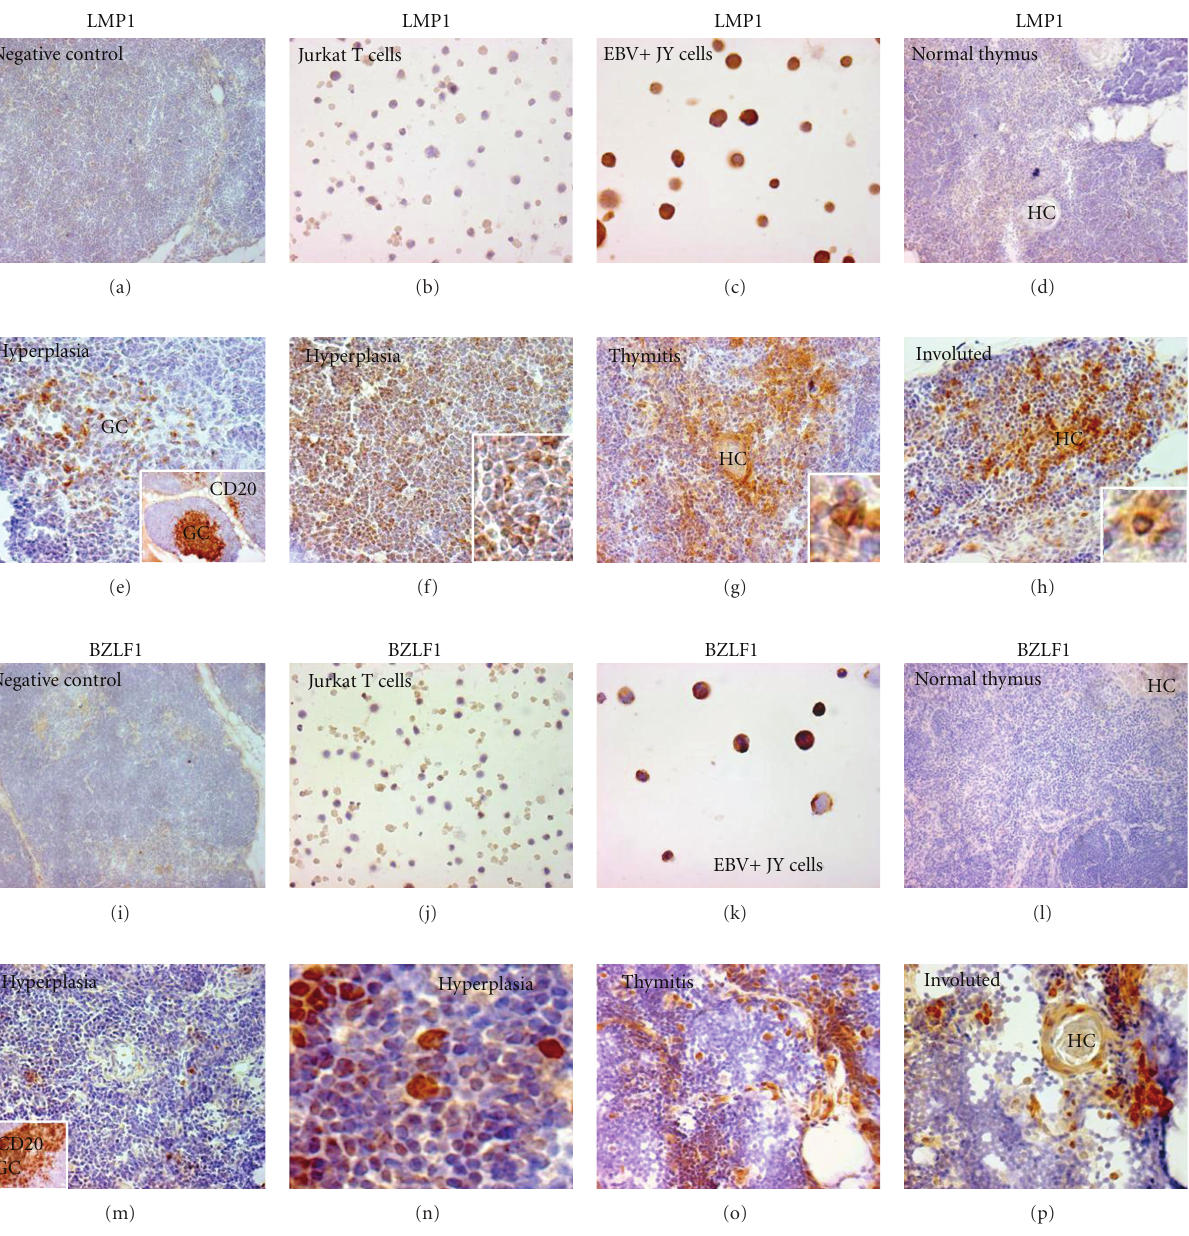
Figure 6: Immunohistochemistry for latent LMP1 (a)–(h) and lytic BZLF1 (i)–(p) EBV proteins. (a) to (h) LMP1 immunostaining. No signal of immunoreactivity was observed in negative control performed by incubating sections with isotype-specific nonimmune IgG (Dako) (a). LMP1 was not detected in EBV-negative Jurkat T-cell line (b) but was readily detectable in EBV-positive JY cells (c). Normal thymuses showed no immunoreactivity for LMP1 antibody (d). In hyperplastic thymuses (MG1 is shown), LMP1+ cells were detected in areas containing CD20+ B cells organized in germinal centers (GCs) ((e) and inset in (e)) or were di ff used throughout the highly infiltrated medullary region (f). Numerous LMP1+ cells were identified in thymitis cases (MG13 is shown), that were di ff used in thymic medulla and frequently located around Hassall’s corpuscles (HCs), where often concentrate B cells (g). In involuted thymuses (MG16 is shown), numerous LMP1+ cells were scattered in the residual thymic parenchyma and frequently located in thymic infiltrated areas around HCs (h). Inset in (e) shows CD20 immunostaining of the same area of the main panel in a serial section. Insets in (f), (g), and (h) show areas of the main panels at higher power of magnification to reveal membrane localization of LMP1. (i) to (p) BZLF1 immunostaining. No signal of immunoreactivity was observed in negative control performed by incubating sections with isotype-specific nonimmune IgG (Dako) (i). BZLF1 was not detected in EBV-negative Jurkat T-cell line (j) but was readily detectable in EBV-positive JY cells (k). Normal thymuses showed no immunoreactivity for BZLF1 antibody (l). In hyperplasia (MG1 is shown), BZLF1+ cells were often detected at the edge of GCs ((m) and inset in (m)) or were scattered in thymic medulla (n). Inset in (m) shows CD20 immunostaining of the same area of the main panel in a serial section. In thymitis (MG11 is shown) (o) and involuted thymuses (MG17 is shown) (p), BZLF1+ cells were present in thymic medulla, in some cases located within medullary infiltrates in proximity to HCs. Magnifications: × 20 (a, d, i, l); × 40 (b, c, e, f, g, h, j, k, m, o, p); × 80